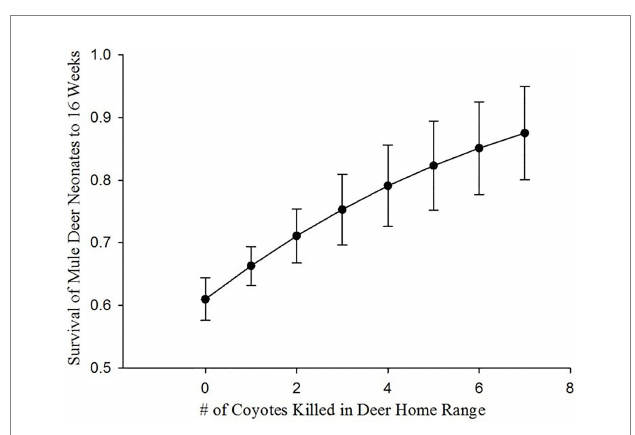
FIGURE 3 Probability of neonate mule deer surviving to 16 weeks of age on Monroe Mountain, Utah, United States during 2012–2015 based on the number of coyotes removed within 2.25 km (average diameter of a mule deer home range) of the birth